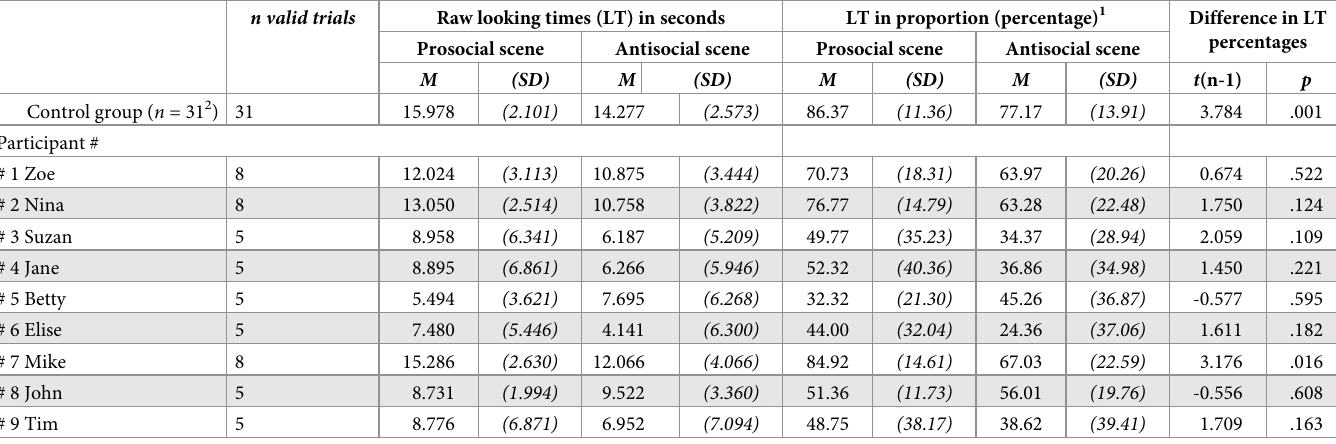
Table 11. Mean (and SD ) looking times (raw and percentage) at each of the two climbing scenes of the SME-Task (i.e., prosocial vs. antisocial scenes) each lasting 15 seconds, of the control group and the nine PIMD participants. Differences in LT percentages were tested using independent t -tests. n valid trials